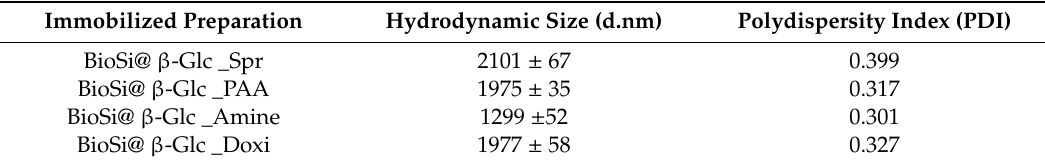
Table 2. Hydrodynamic size of the immobilized preparations.